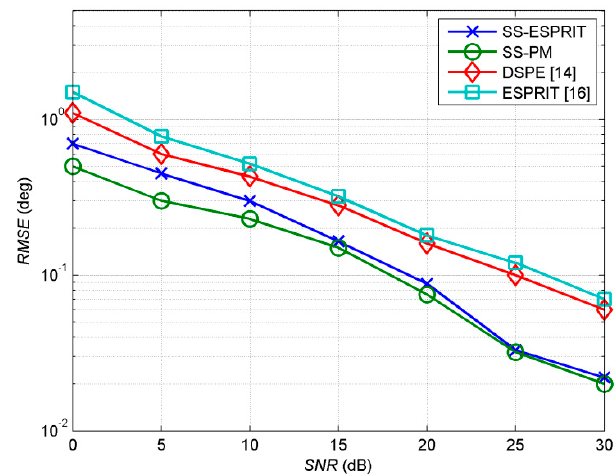
Figure 2. RMSE estimated by proposed methods for 2D CD sources uncorrelated with each other.